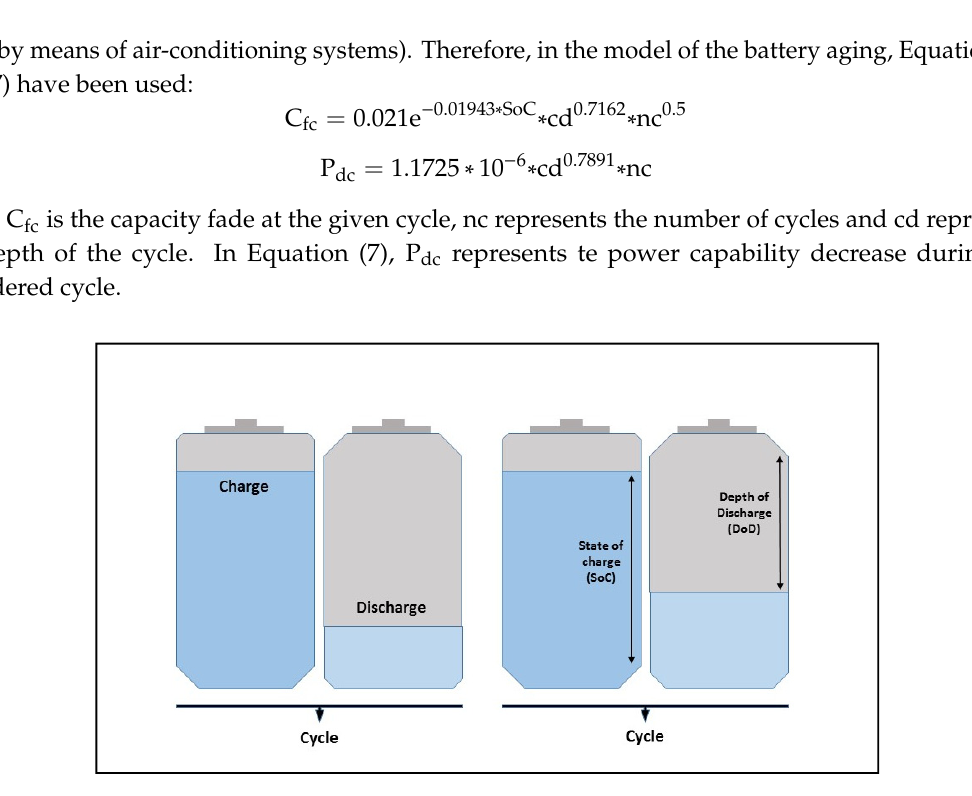
Figure 1. The battery cycle working principle, state of charge (SoC) and depth of discharge (DoD).